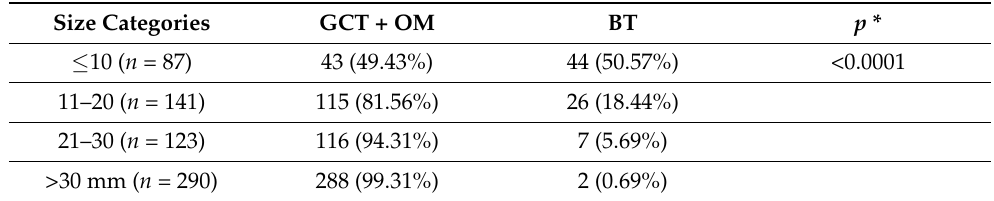
Table 6. Frequency distribution of malignant tumours and benign testicular tumours in four tumour size